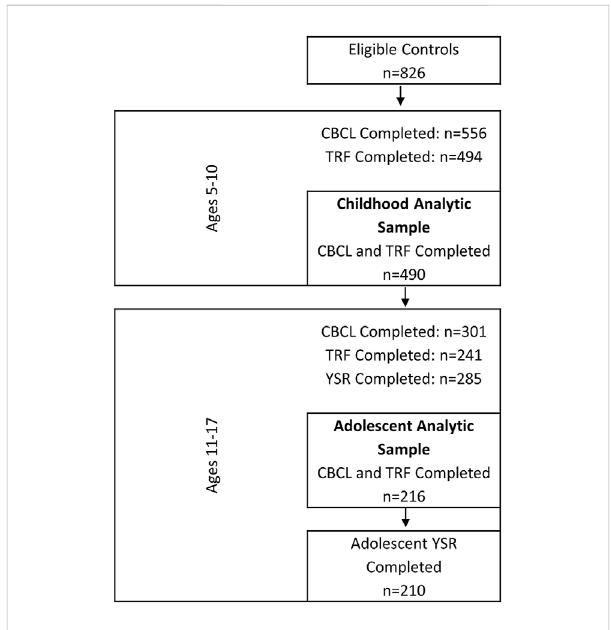
FIGURE 1 Flow diagram of eligible controls from the case-control study and number of participants at childhood and adolescent behavioral